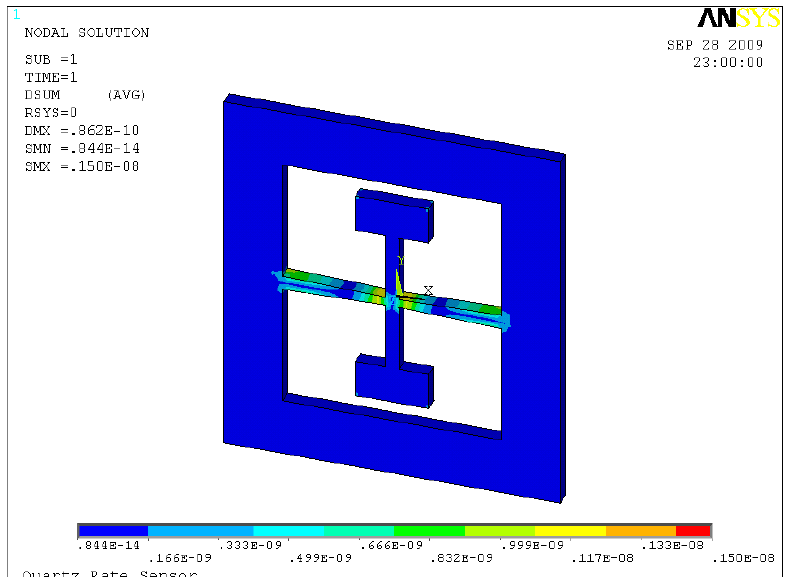
Figure 7. Electric displacement distribution by static